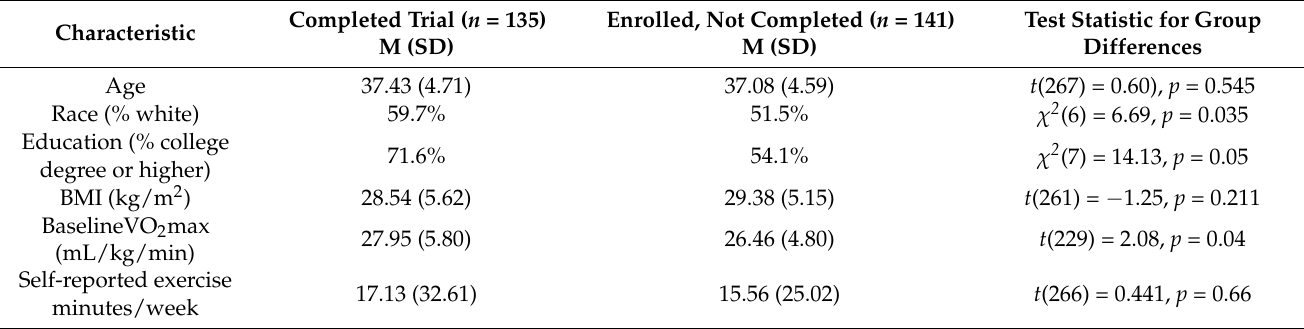
Table 2. Demographic and participant characteristics for study completers vs.